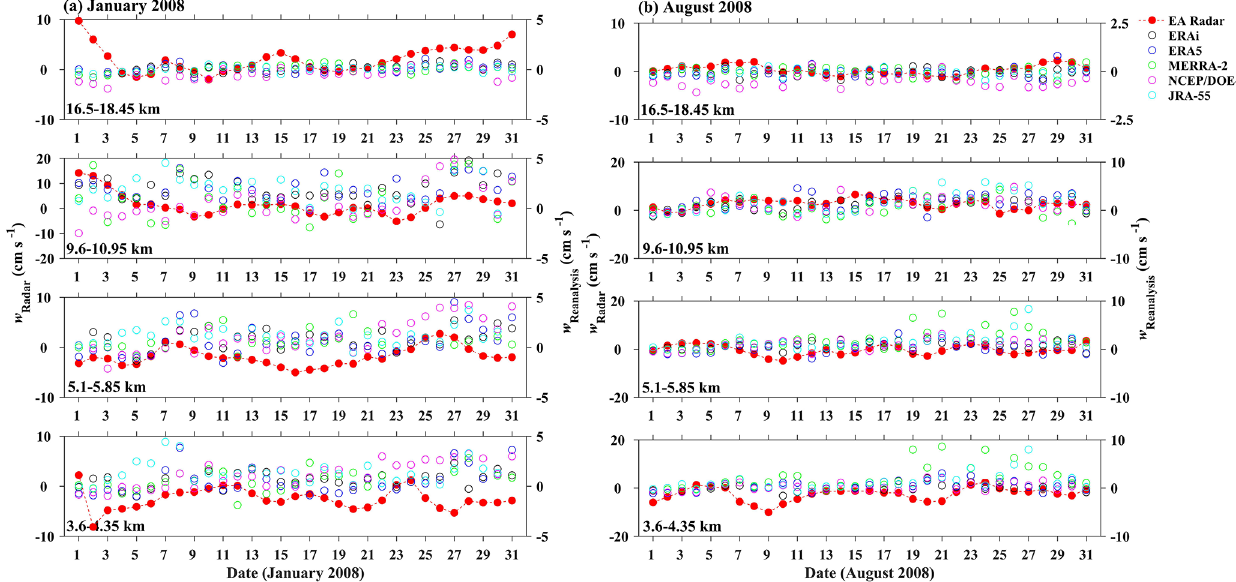
Figure 3. Same as Fig. 2 but for EAR over Kototabang. Please note that w is the diurnal mean (24h mean) for both EAR and reanalyses for (a) January 2008 and (b) August